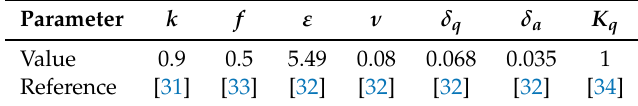
Table 2. Numerical values of constant parameters related to the mosquito life